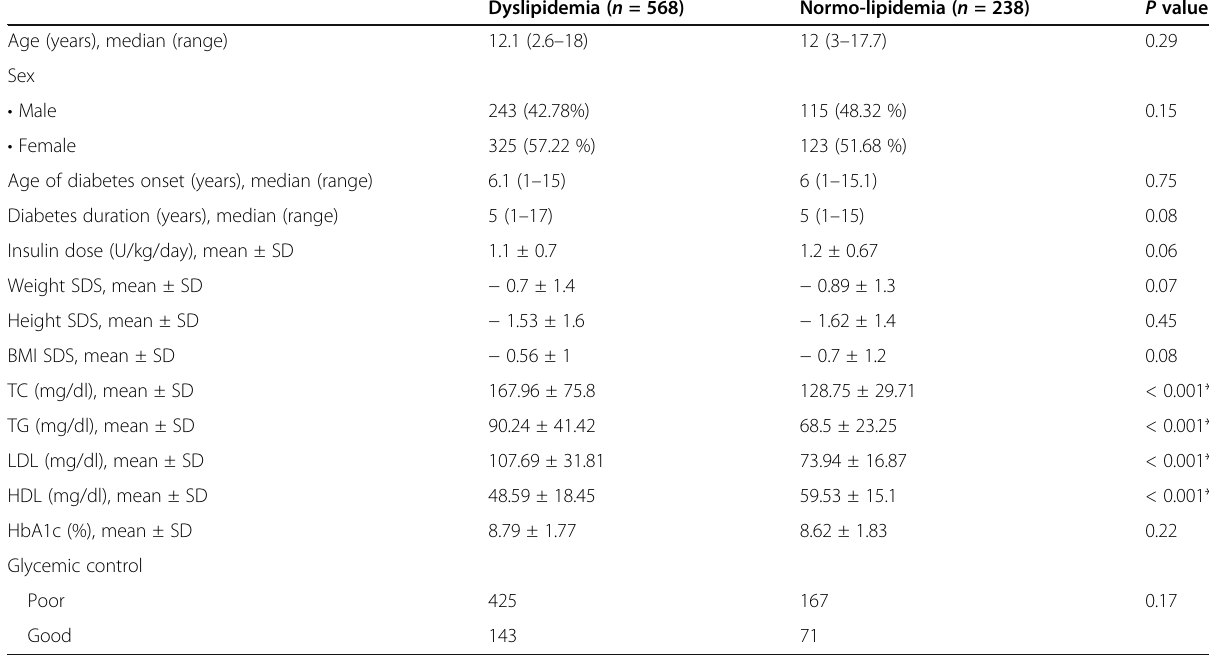
Table 2 Demographic and laboratory data of patients with and without dyslipidemia Dyslipidemia ( n = 568)